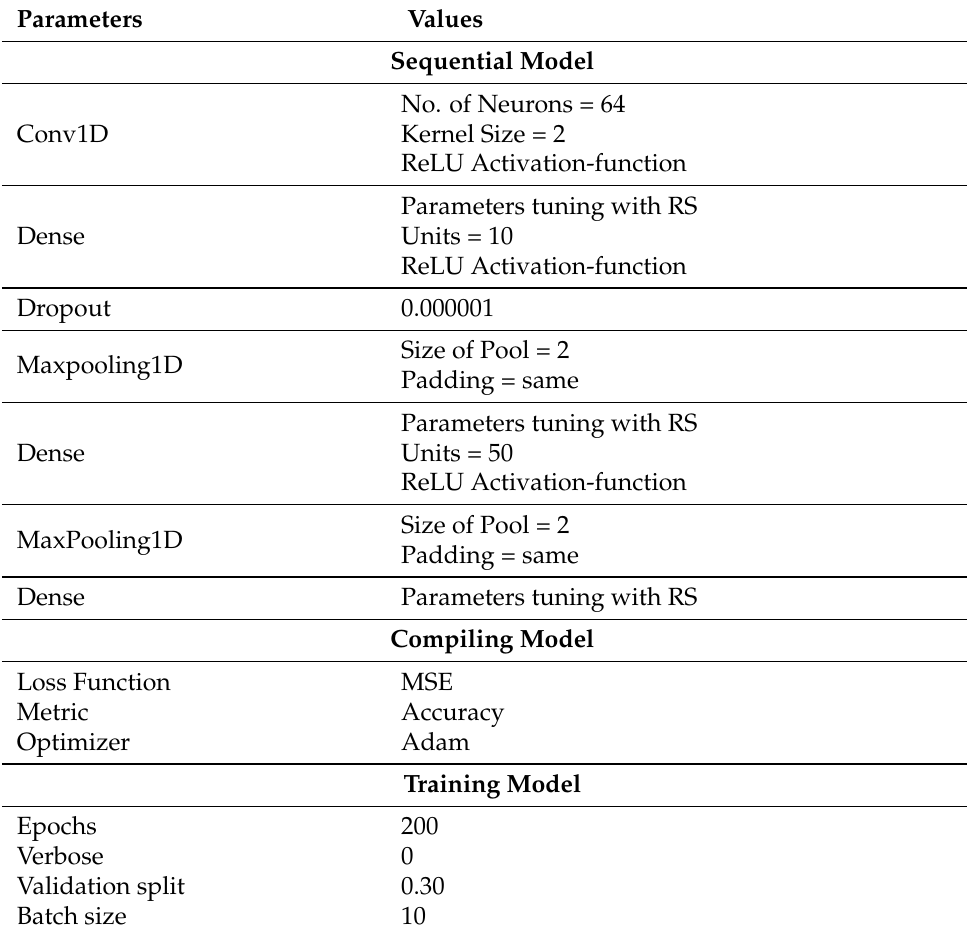
Figure 5. System model of proposed enhanced support vector machine (ESVM). Table 1. Layers and parameters used for proposed